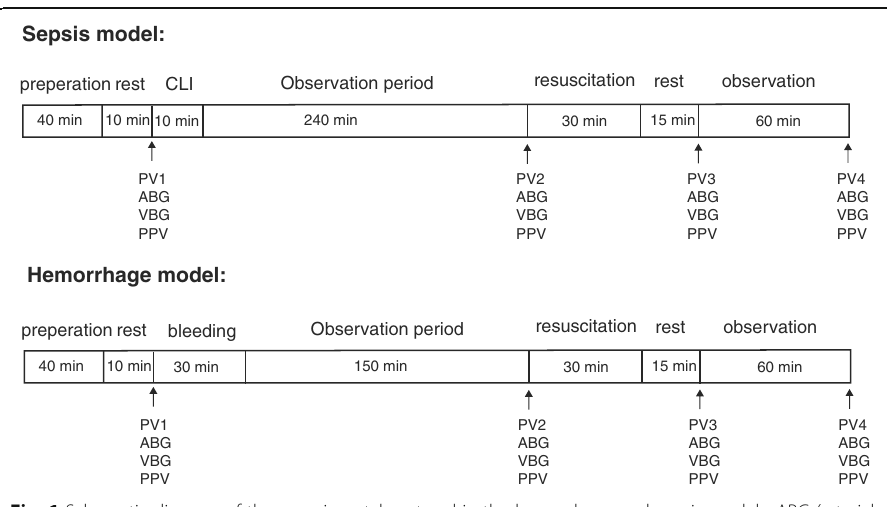
Fig. 1 Schematic diagram of the experimental protocol in the hemorrhage and sepsis models. ABG (arterial blood gas), CLP (cecal ligation and puncture), PPV (pulse pressure variation), PV (plasma volume), VBG (venous blood